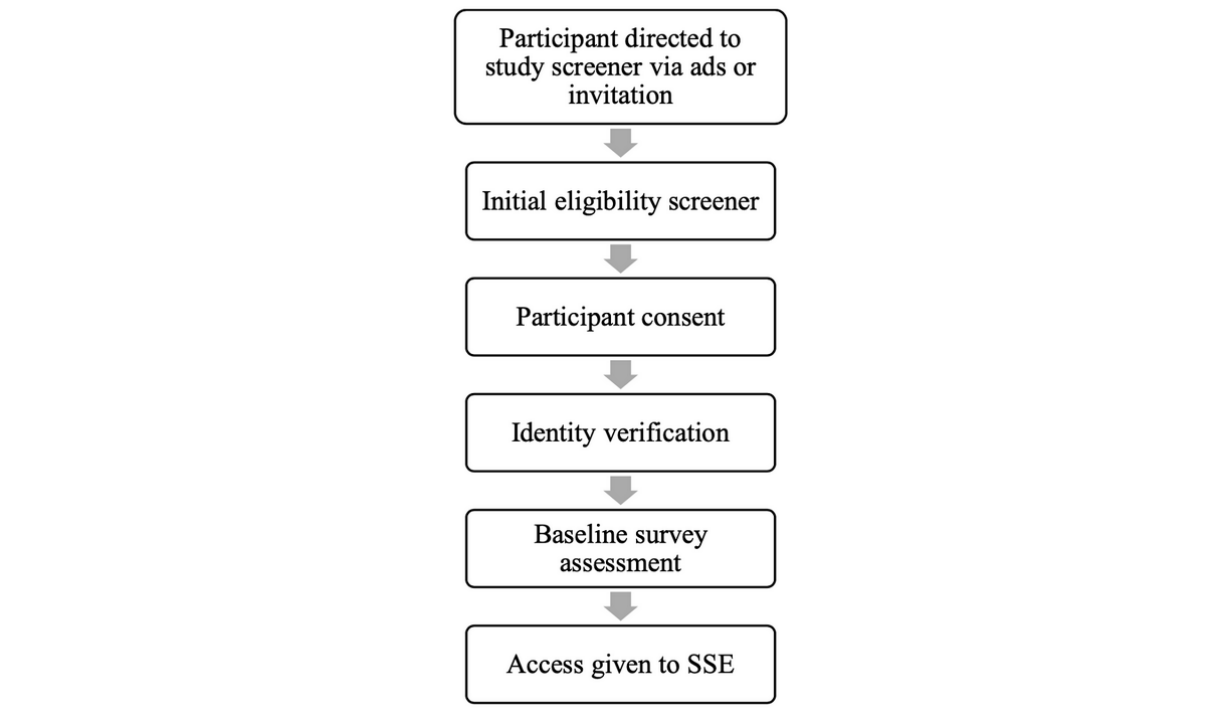
Figure 2. Participant entrance into SMART: from advertisement to enrollment. SSE: SMART Sex